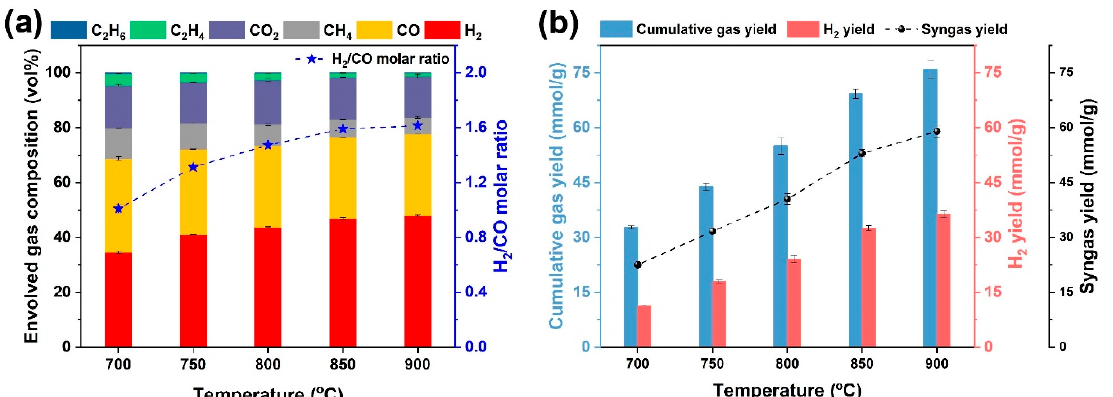
Figure 5. Gas formation behaviors from steam gasification of raw WS with regard to gasification temperature: ( a ) evolved gas composition and H 2 /CO molar ratio and ( b ) cumulative gas yield, H 2 yield, and syngas yield.